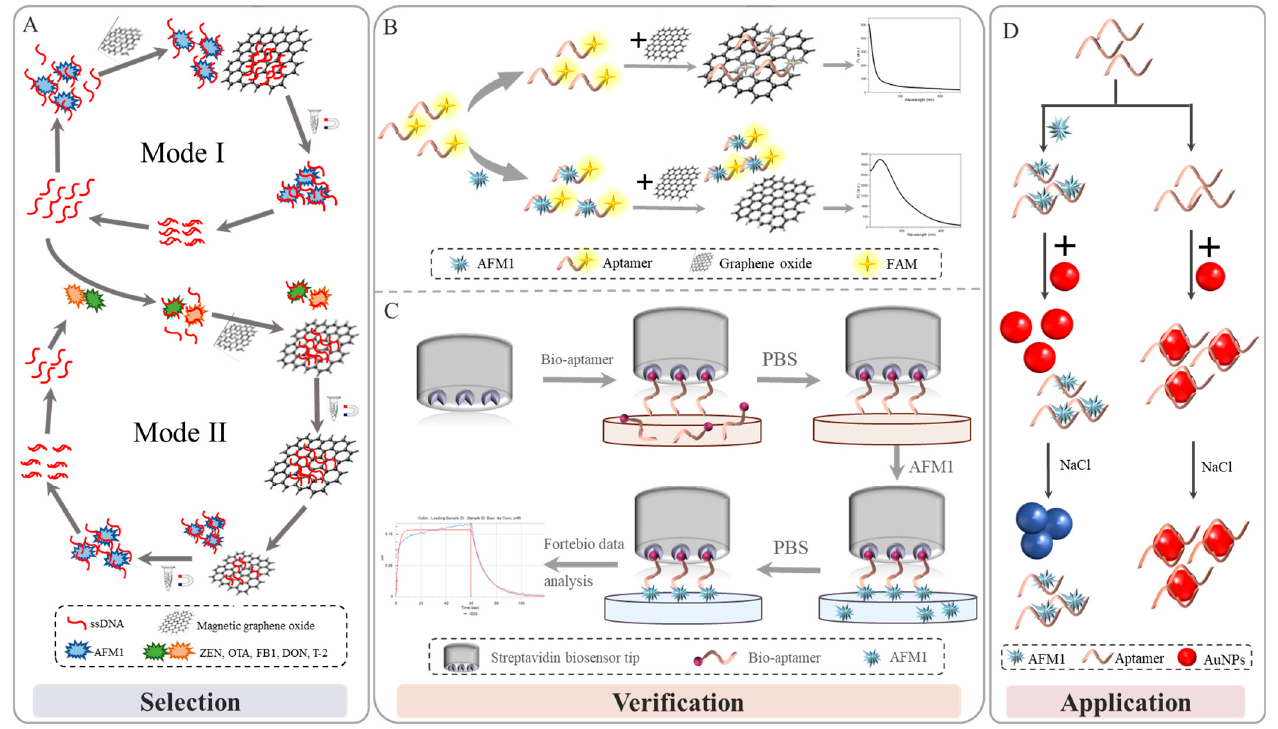
Figure 1. Schematic diagram ( A ) MGO-SELEX. ( B ) Fluorescence-affinity detection method. ( C ) BLI- affinity detection method. ( D ) Aptamer-AuNPs colorimetric method for detection of AFM1.